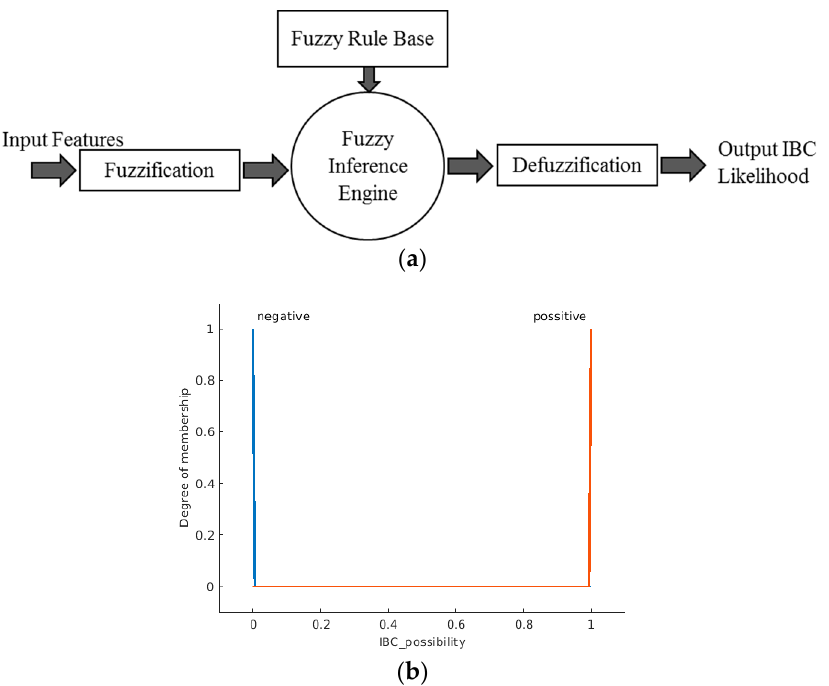
Figure 7. ( a ) The architecture of the proposed Type-1 fuzzy inference system. ( b ) Singleton output membership function used in the designed Type-1 fuzzy system.